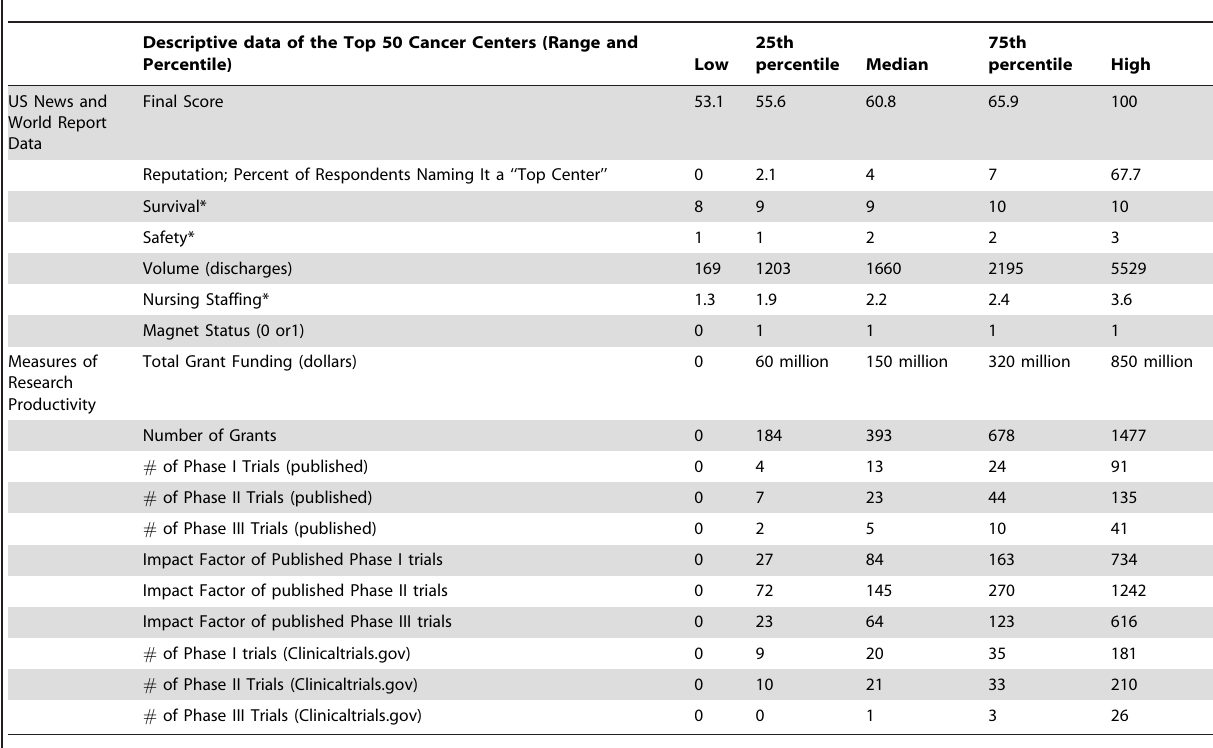
*Standardized units.